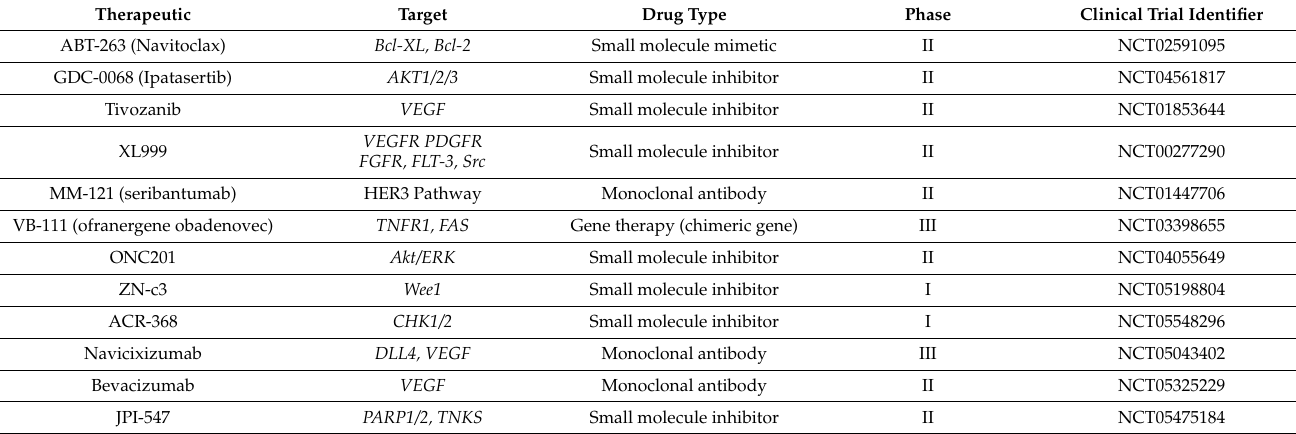
Table 2. Therapies in clinical trials for the treatment of drug-resistant/recurrent ovarian cancer in the